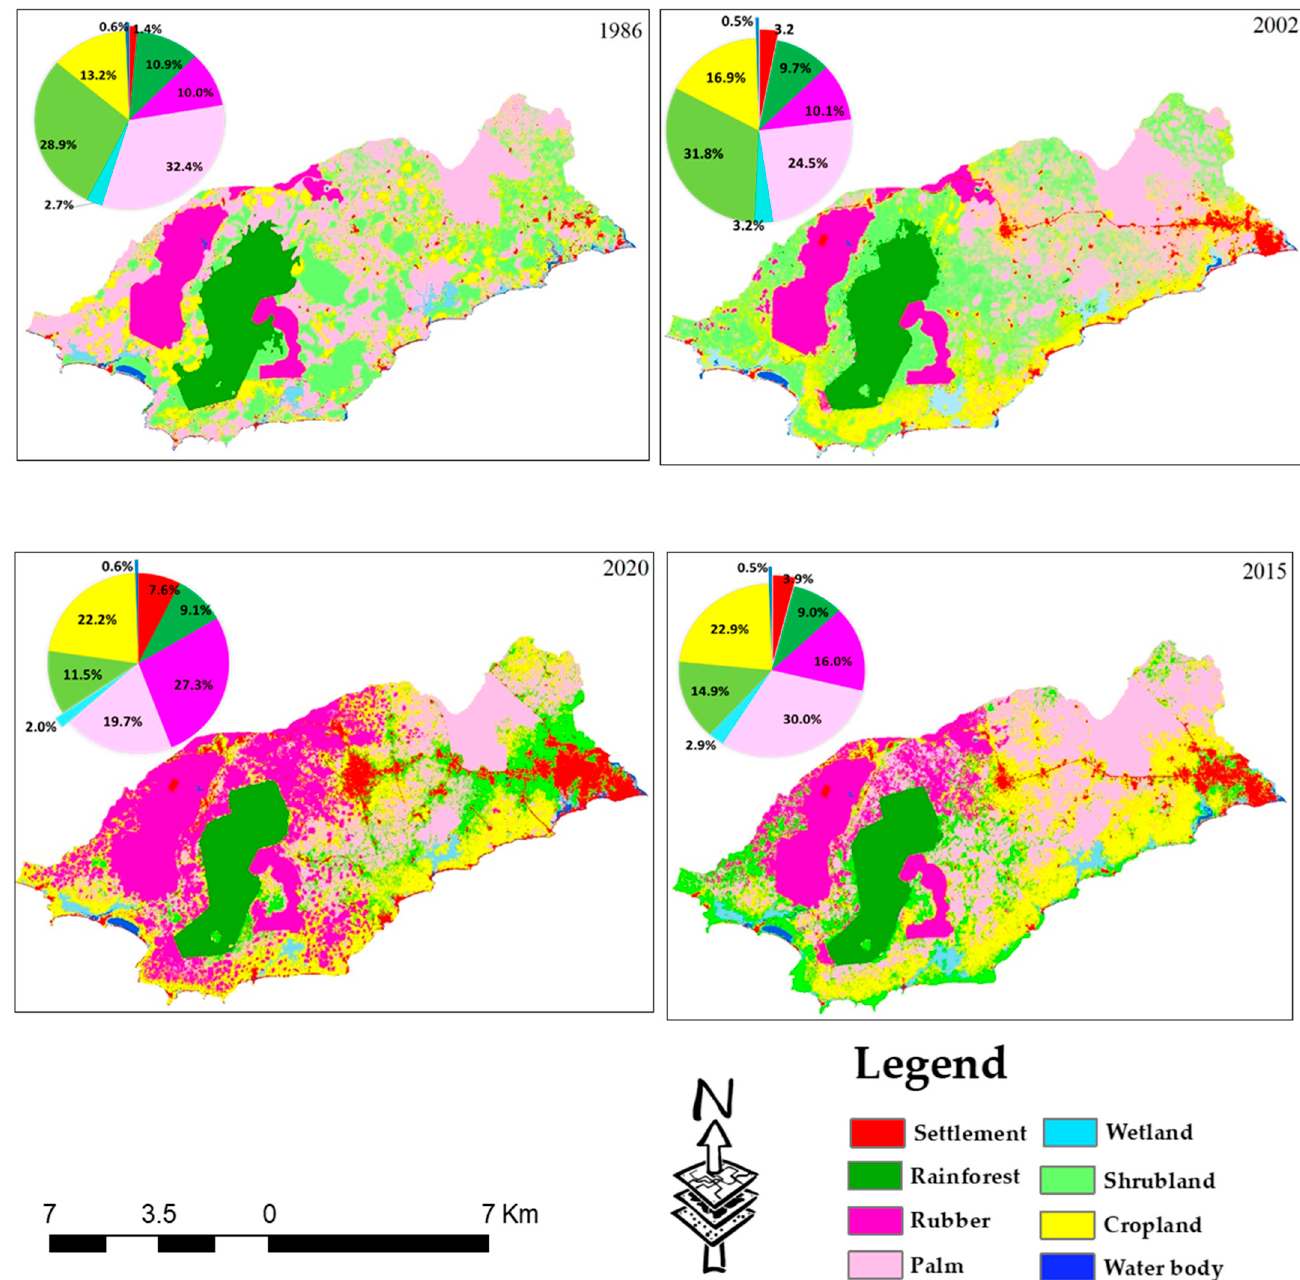
Figure 4. Land cover maps and percentage land share of each land cover types for the years 1986, 2002, 2015 and 2020.